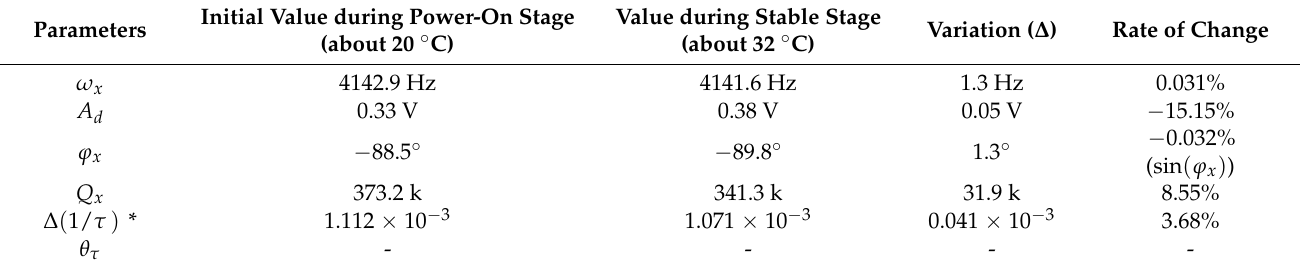
Table 2. Measurement of parameter changes during gyroscope power on